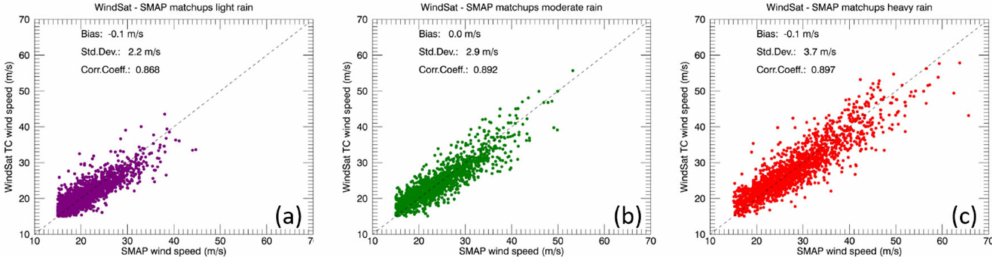
Figure 4. Testing of WindSat TC algorithm in 3 different rain regimes. The figures show scatterplots between the SMAP and the retrieved WindSat TC wind speeds of the SMAP–WindSat match-up set that was reserved for algorithm testing (Section 2.1). Only observations for which both wind speeds are above 15 m/s are included. ( a ) Light rain (WindSat rain rate above 0 and below 4 mm/h). ( b ) Moderate rain (WindSat rain rate above 4 and below 8 mm/h). ( c ) Heavy rain (WindSat rain rate above 8 mm/h). The values of the bias, standard deviation and the linear correlation coefficient are indicated in each